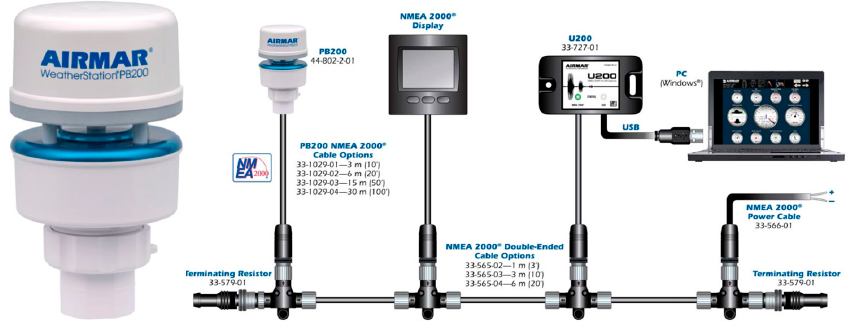
Figure 5. AIRMAR PB200 Weather Station.